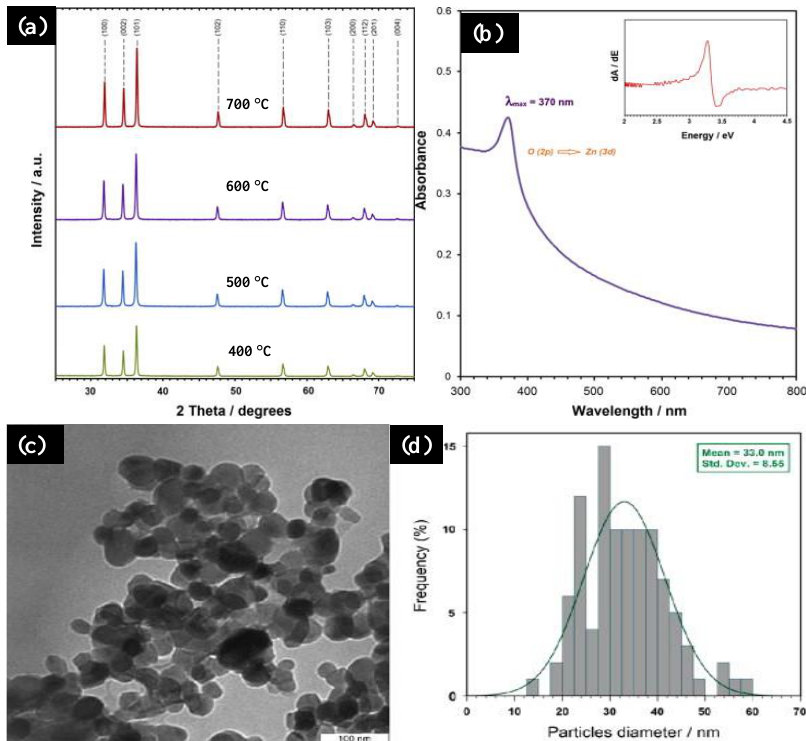
Figure 4. ( a ) XRD plot of synthesized ZnO NPs at different calcinations at 600 °C. ( b ) The UV-Vis spectra of the ZnO NPs synthesized at 600 °C. ( c , d ) TEM image and particle size distribution of ZnO NPs in gum tragacanth (GT) media synthesized at 600 °C. Figure adapted with permission from Reference [41] Copyright 2013 Elsevier. Table 2. Biosynthesis approaches to synthesize ZnO NPs from different plant sources. Morphology/Shape